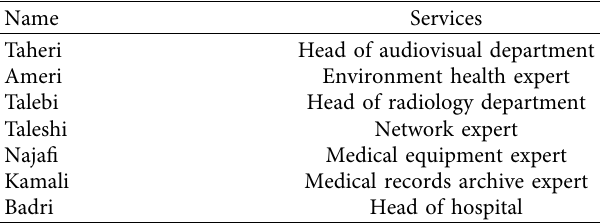
Table 2: Names of employees in a hospital and their